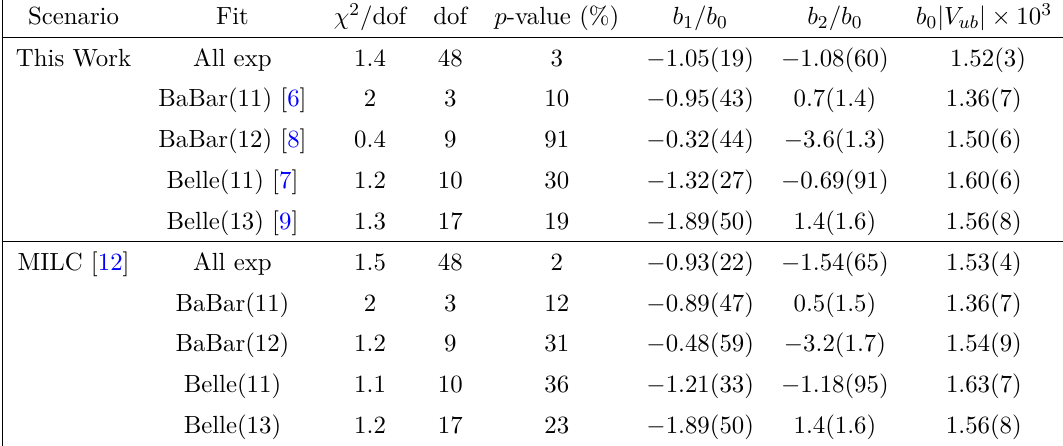
Table 3 . Comparison between table XV of ref. [12] (MILC) and the results of this work. Details are in the